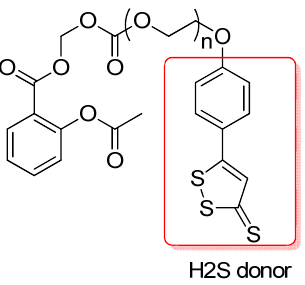
S donor properties (n = 0; n = 2